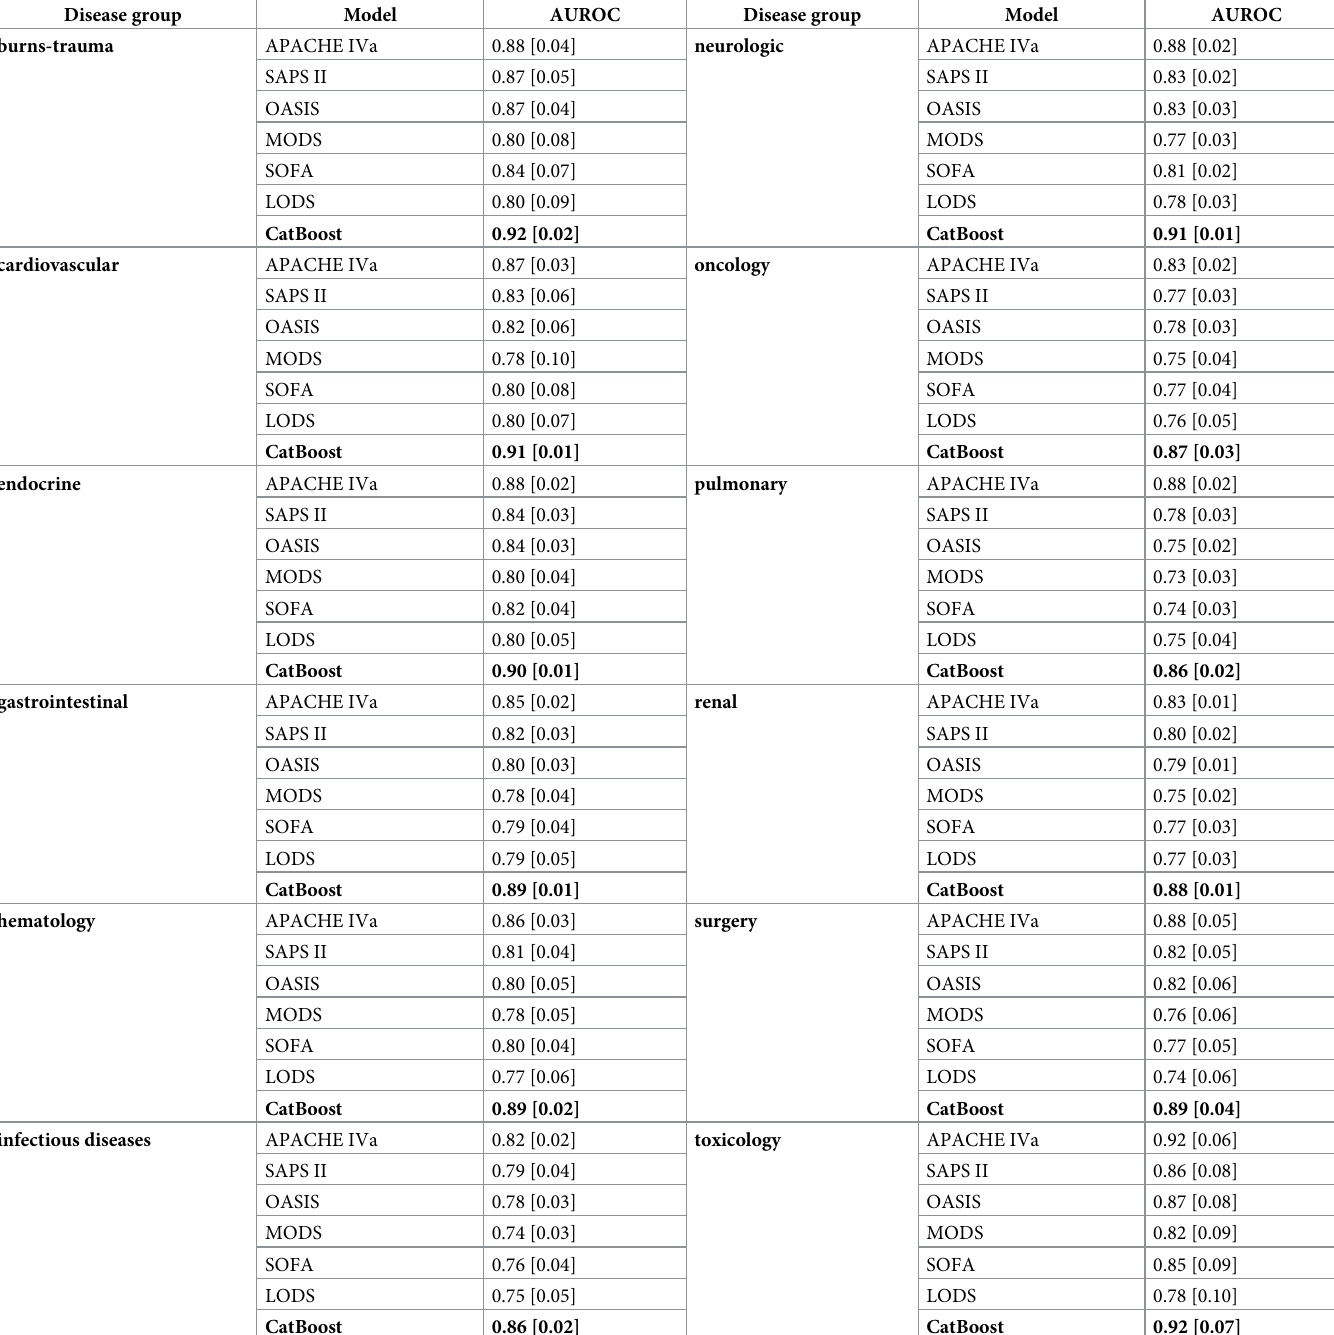
Table 4. Cross-validation results (AUROC) of CatBoost and ICU illness severity scoring systems using 10-fold cross-validation. Disease